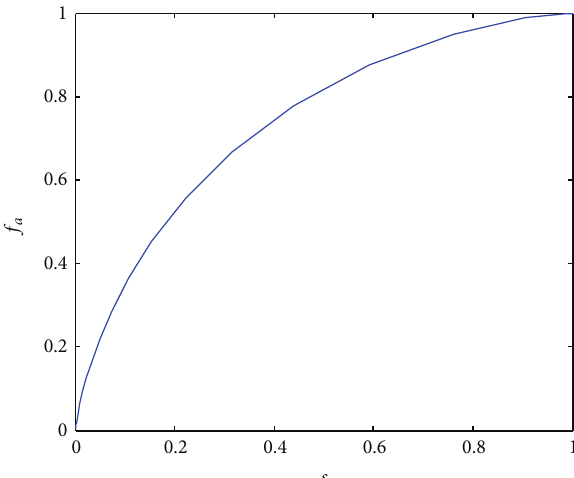
Figure 7: Fractional flow function for accessible